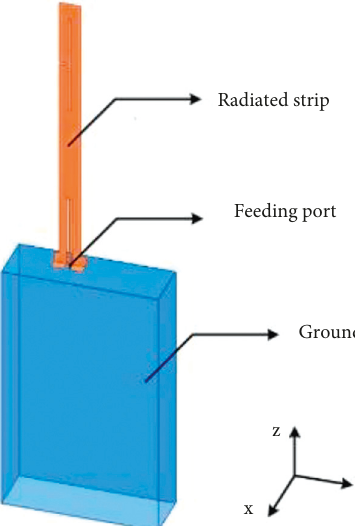
Figure 1: The structure of the proposed antenna.